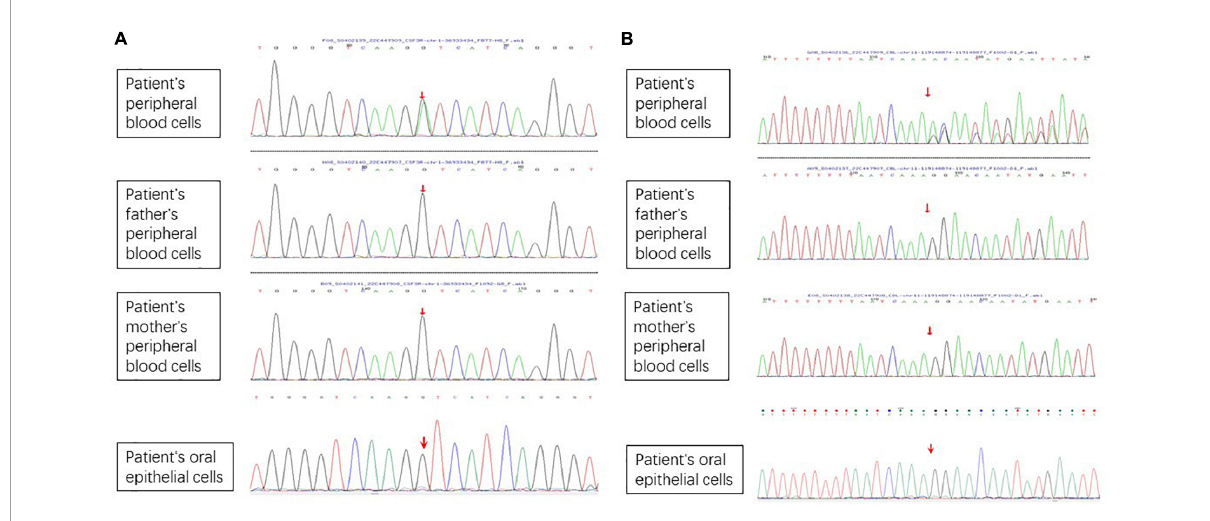
FIGURE3 Genomic analysis revealed a CSF3R T618I somatic mutation and a CBL c.1096-1_1097delGGA frameshift somatic mutation. (A) CSF3R T618I somatic mutation. (B) CBL c.1096-1_1097delGGA frameshift somatic mutation.